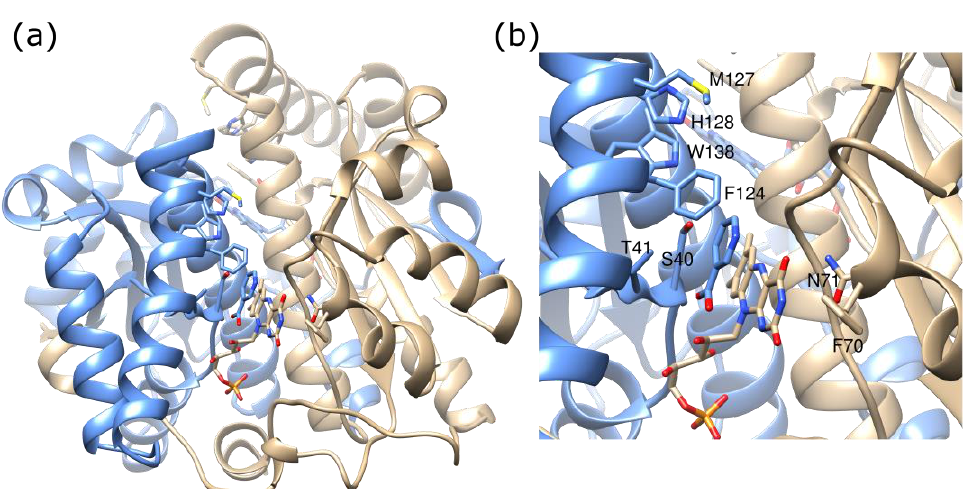
Figure 4. Ribbon diagram of wild-type protein showing positions mutated. ( a ) Structure of full protein with one subunit in blue and the other in tan, from 1ICR [30]. The side chains of mutated residues are shown in full and coloured in CPK colours, as are the FMN and bound nicotinate. ( b ) Close-up of the active site, in the same orientation as in Figure ( a ), with the mutated residues labelled. After 15 rounds of selection, the mutations contained L or Q at position 41, only S at 71, F or T at 124, and a variety of hydrophobic residues at 127. IC 50 colony assays suggested